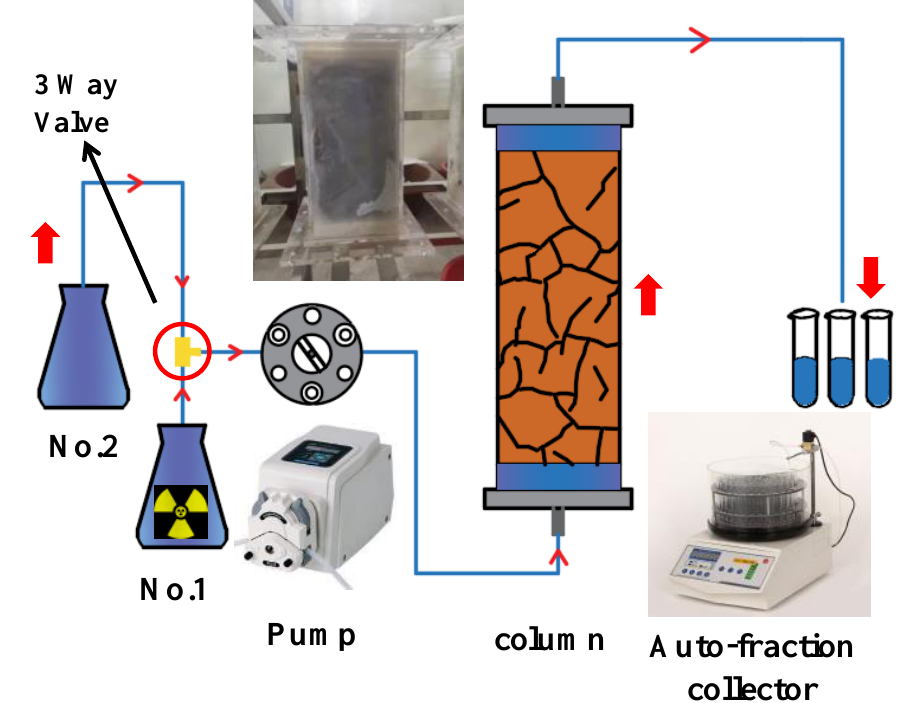
Figure 1. A reliable ADE device with a glass column apparatus in this study. Table 1. The experimental glass filled and compacted with crushed granite.